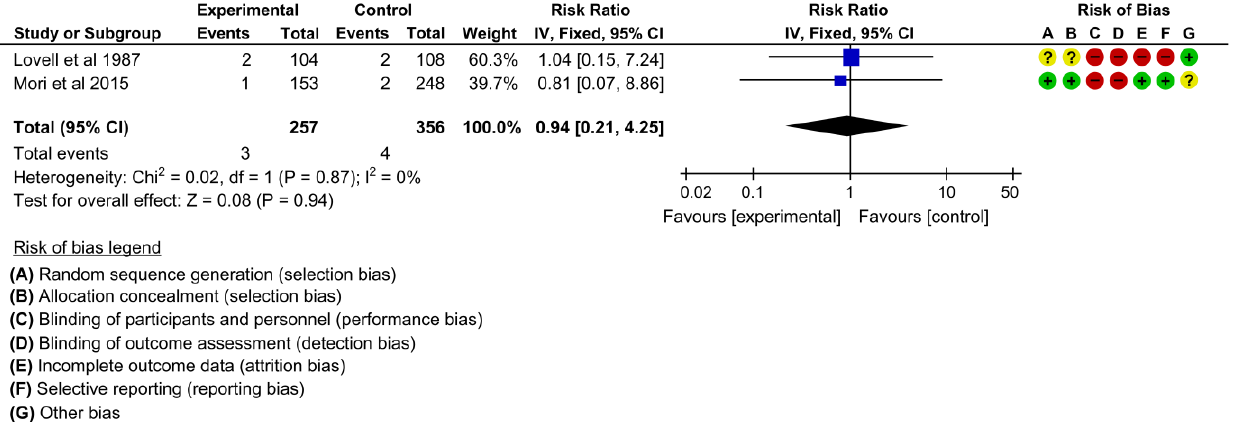
Figure 9. Meta-analysis for the effect of MCH handbook interventions vs. standard care on stillbirth or neonatal death [19,22]. Red color with a − symbol means a high risk of bias, yellow color with a ? symbol means an unclear risk of bias, and green color with a + symbol means a low risk of